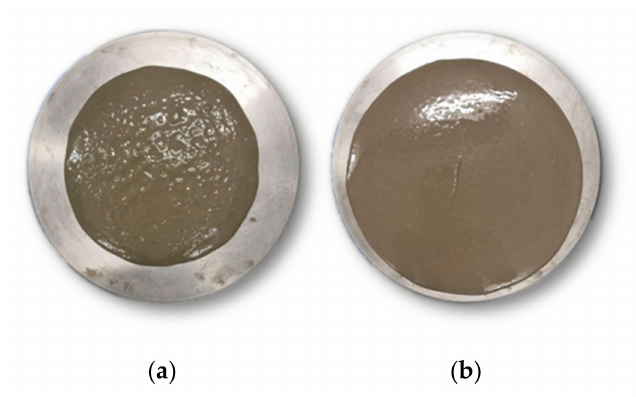
Figure 3. Consistency after mixing (5 min): ( a ) REF_0.4; ( b )